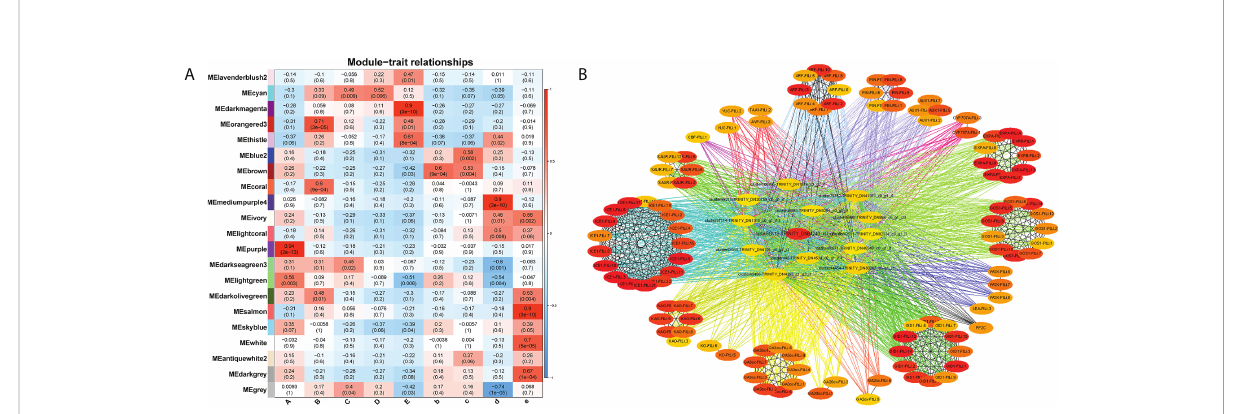
FIGURE 5 WGCNA of DEGs between the 9 development stages. (A) Module – trait association of the 9 sample groups (A, B, C, D, E, b, c, d and e). Each row corresponds to a module labeled with a colour. Each column corresponds to one sample group. (B) Interaction network analysis of the MEdarkmagenta module. The top 120 hub genes were used to build interaction network diagram in the MEdarkmagenta module. Dots represent hub genes. All details are listed in Supplementary Tables 9,